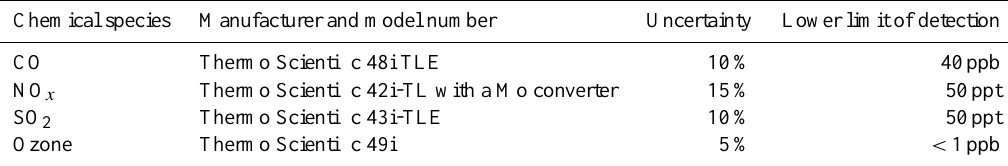
Table 1. Analytical characteristics of trace gas analyzers at TRF. Chemical species Manufacturer and model number Uncertainty CO Thermo Scientific 42i-TL with a Mo converter SO 2 Thermo Scientific 43i-TLE Ozone Thermo Scientific